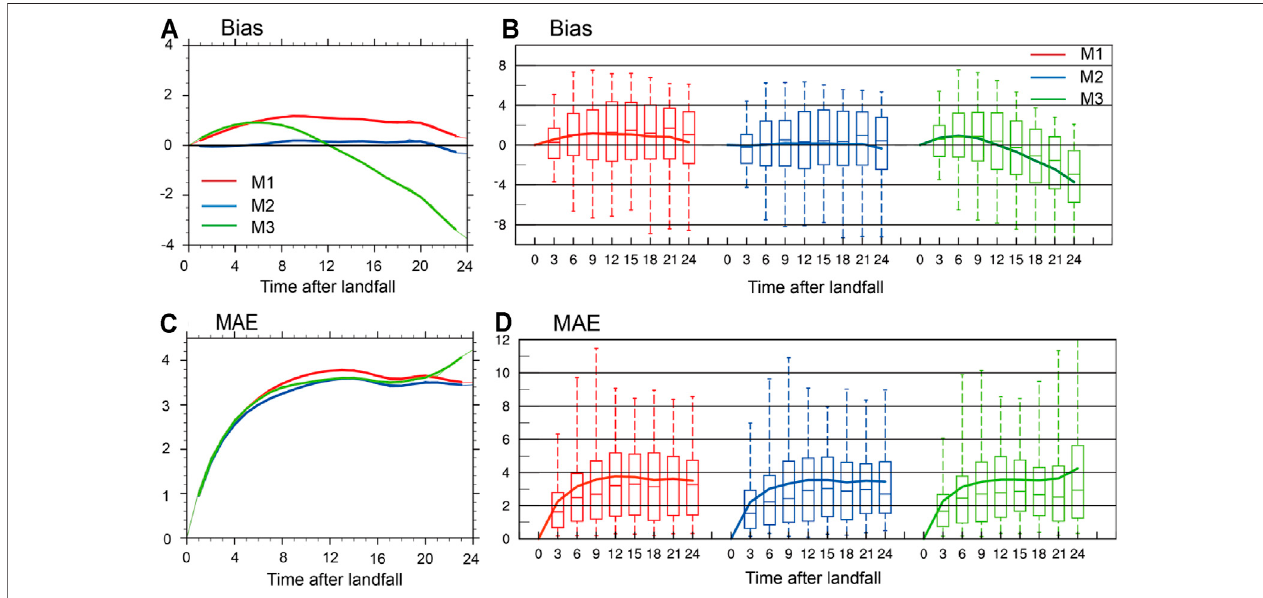
FIGURE 3 | Distribution of biases [ (A, B) , m s − 1 ] and mean absolute errors [MAE, (C, D) , m s − 1 ] of M1 (red), M2 (blue) and M3 (green) for TCs making landfall over China during 1980 – 2018. The top (bottom) of each vertical line means the 95th (5th) percentile, the upper (lower) bound of each box means the 75th (25th) percentile, andthehorizontallineineachboxmeansthemedian.Thesolidcurvedenotestheaverageintensityin (B,D) .Theboldcurvesshowthe3-pointrunningaveragein (A,C) .